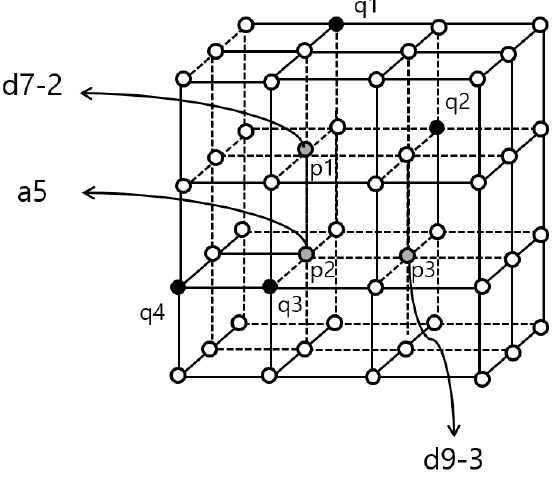
Figure 7. An example of disconnection.